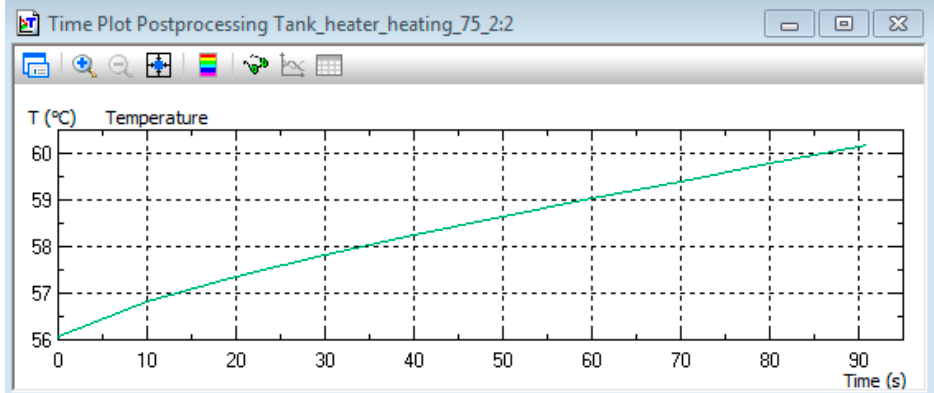
Figure 14. The temperature changes of the AMD ferrite ring during the heating process for 91 s.